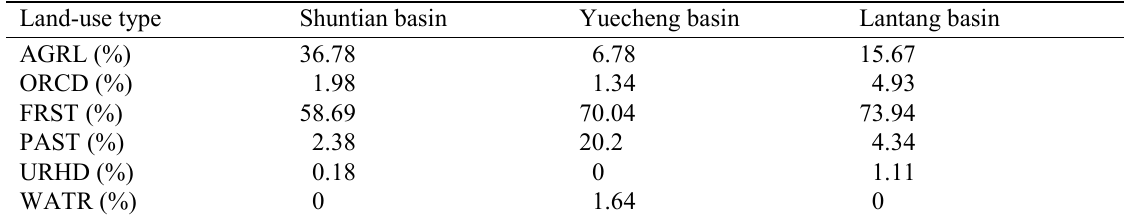
Table 2 The detailed information of the land-use